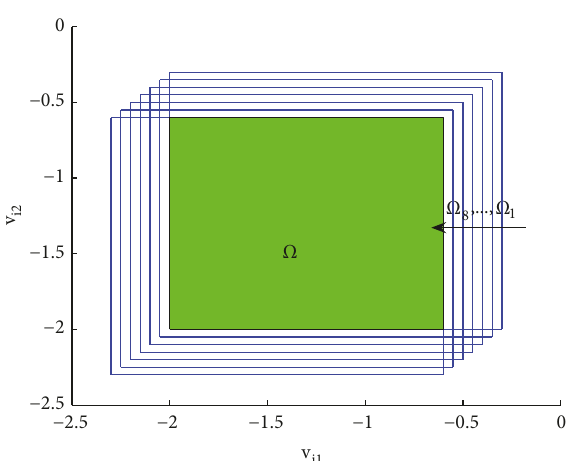
Figure 2: The local constraint set Ω 𝑖 and the intersection Ω .